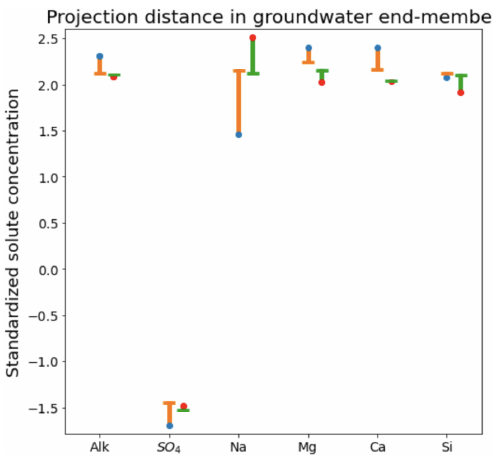
Figure 4. Comparison of orthogonal projection distance for field- measured and CHEMMA-predicted groundwater end-member so- lute concentrations (in standardized units). For each solute, the blue and red dots are the observed and CHEMMA-estimated end- member concentrations, respectively. The orange and green bars show how these concentrations change when the end-members are projected in the 2D subspace (formed by retaining only the first two PC). The CHEMMA end-members lie closer to the 2D sub- space that PCA analysis suggests the data principally occupy, so their projection distances are